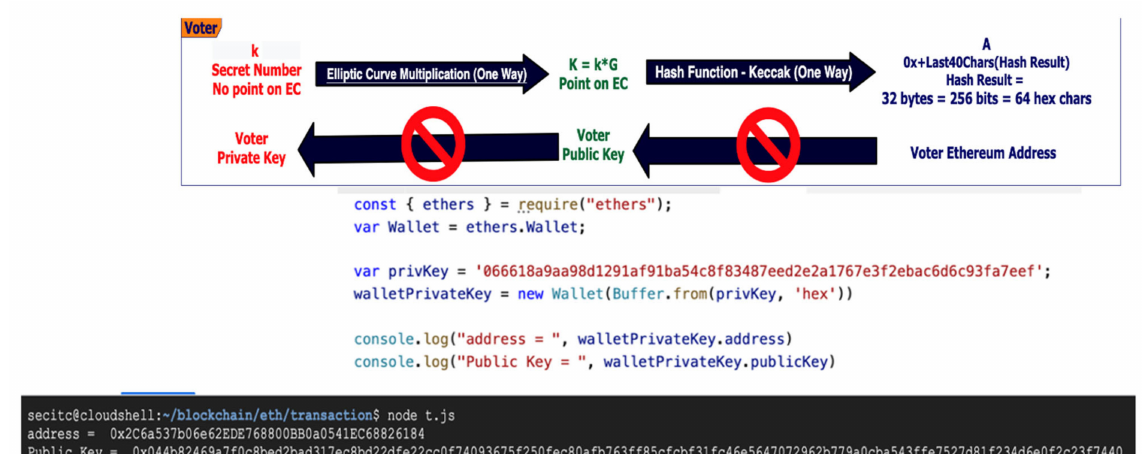
Figure 5. Ethereum Address generation using node.js ethers.io module using private key.